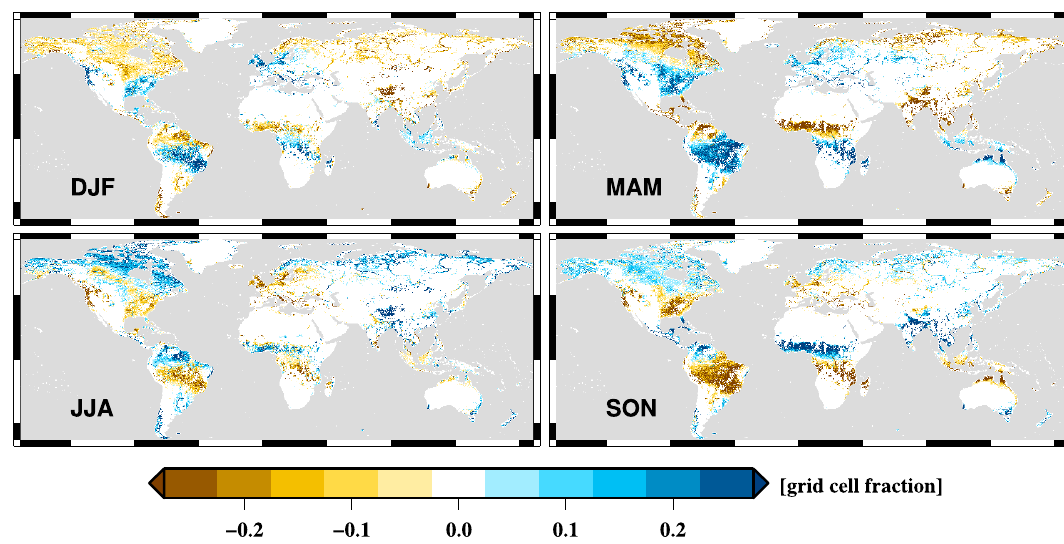
Fig. 7. Deviation of the wetland fraction from its yearly mean for all seasons as simulated by the